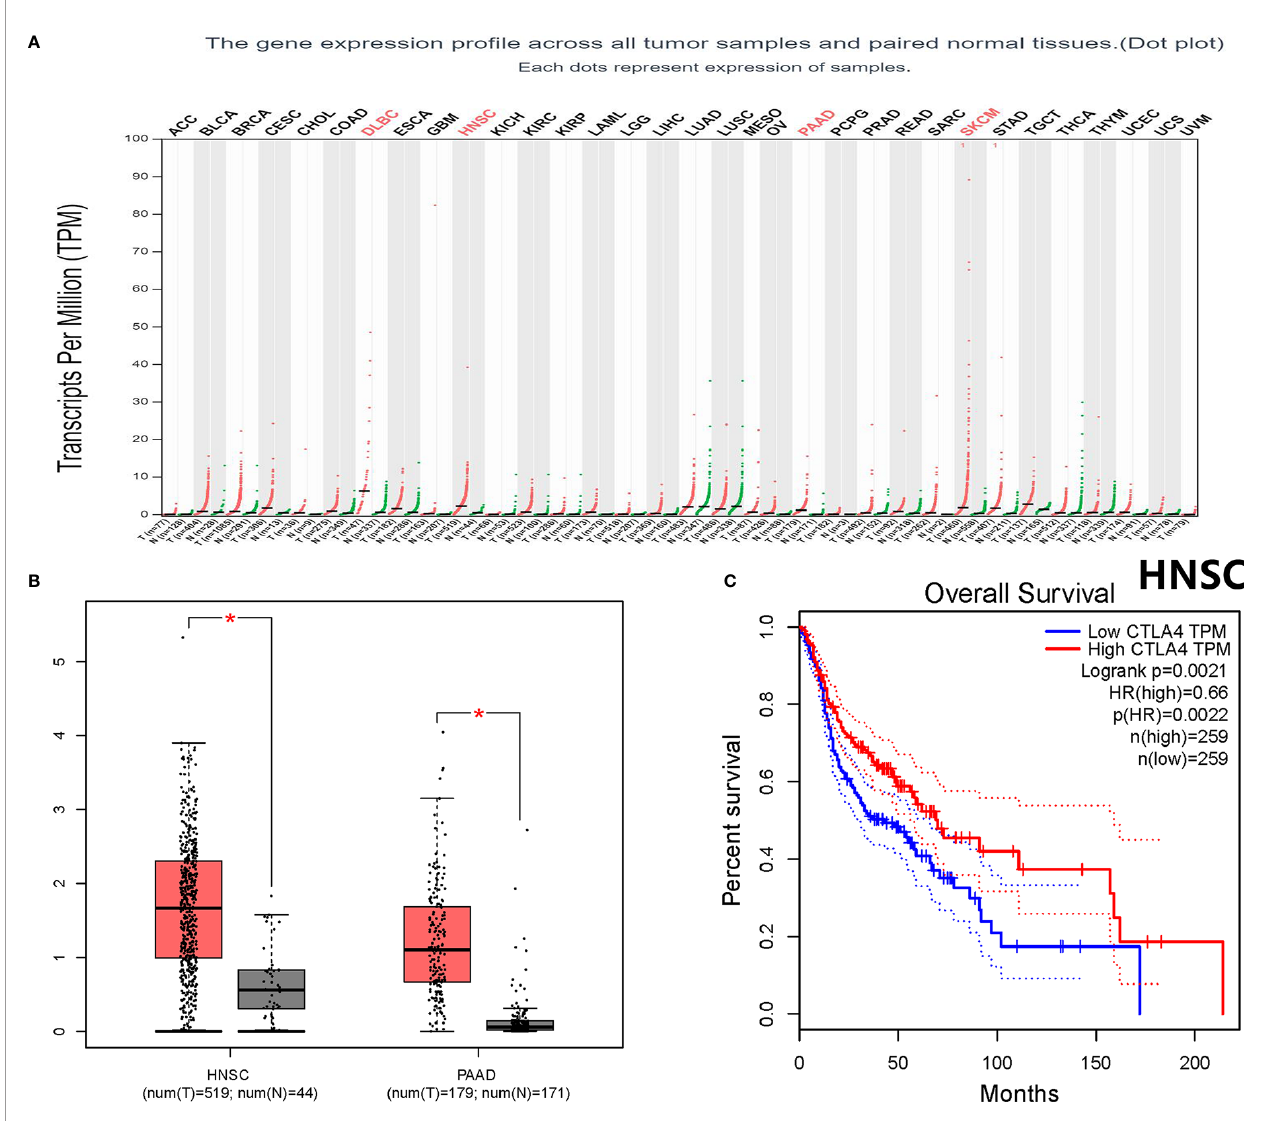
FIGURE 3 | Bioinformatics analysis about the CTLA-4 gene. (A) The CTLA-4 gene expression pro fi le across all tumor samples and paired normal tissues. (B) CTLA- 4 gene expression both in HNSC and PAAD. *P < 0.05. (C) Overall survival analysis for HNSC. HR, hazard ratio; ACC, adrenocortical carcinoma; BLCA, bladder urothelial carcinoma; BRCA, breast invasive carcinoma; CESC, cervical squamous cell carcinoma and endocervical adenocarcinoma; CHOL, cholangiocarcinoma; COAD, colon adenocarcinoma; DLBC, lymphoid neoplasm diffuse large B-cell lymphoma; ESCA, esophageal carcinoma; GBM, glioblastoma multiforme; HNSC, head and neck squamous cell carcinoma; KICH, kidney chromophobe; KIRC, kidney renal clear cell carcinoma; KIRP, kidney renal papillary cell carcinoma; LAML, acute myeloid leukemia; LGG, brain lower grade glioma; LIHC, liver hepatocellular carcinoma; LUAD, lung adenocarcinoma; LUSC, lung squamous cell carcinoma; MESO, mesothelioma; OV, ovarian serous cystadenocarcinoma; PAAD, pancreatic adenocarcinoma; PCPG, pheochromocytoma and paraganglioma; PRAD, prostate adenocarcinoma; READ, rectum adenocarcinoma; SARC, sarcoma; SKCM, skin cutaneous melanoma; STAD, stomach adenocarcinoma; TGCT, testicular germ cell tumors; THCA, thyroid carcinoma; THYM, thymoma; UCEC, uterine corpus endometrial carcinoma; UCS, uterine carcinosarcoma; UVM, uveal